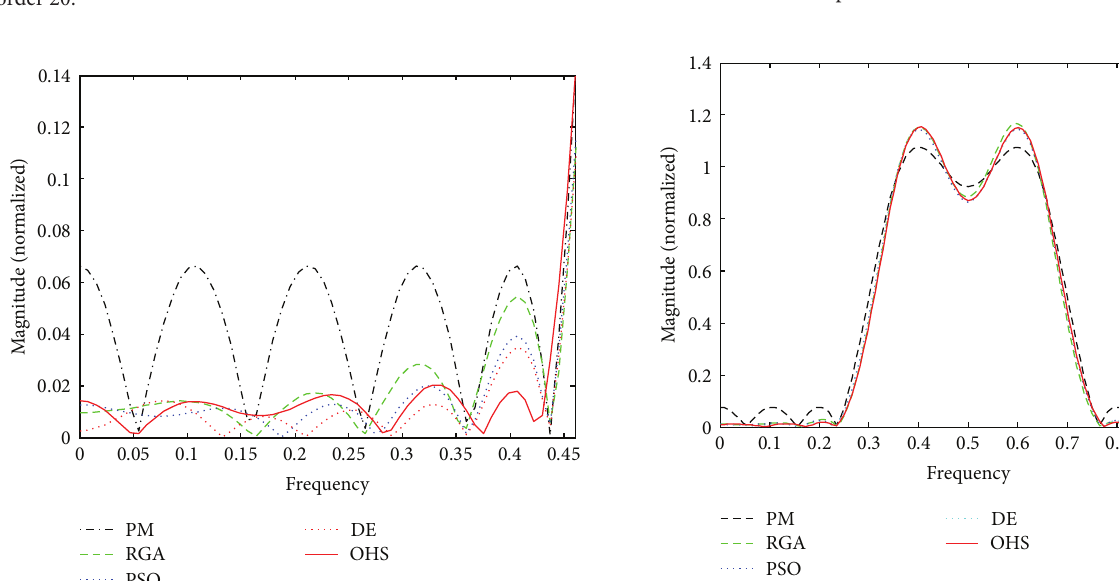
Figure 9: dB plots for the FIR BP filter of order 20.